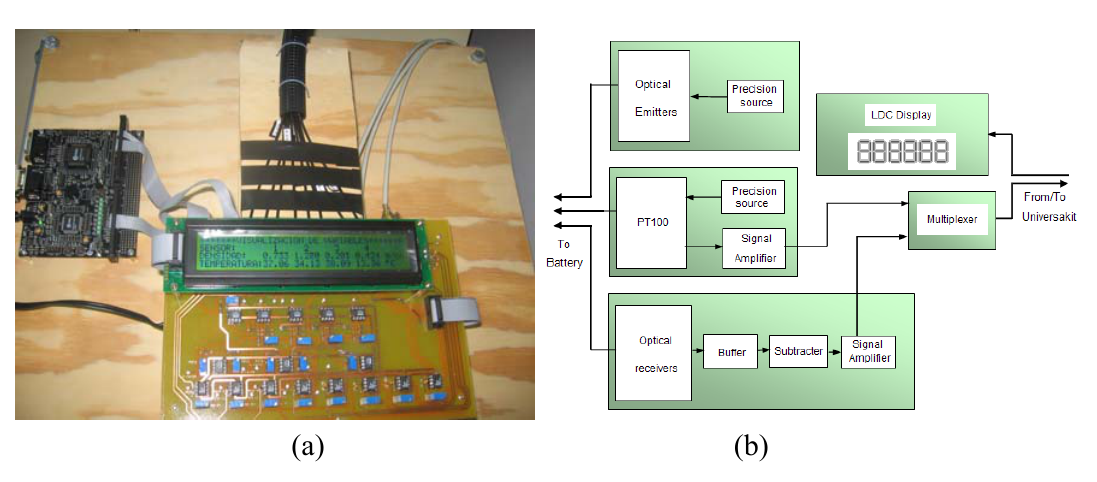
Figure 19. System for conditioning and visualization of the variables of the optoelectronic sensor. (a) Photograph. (b) Block